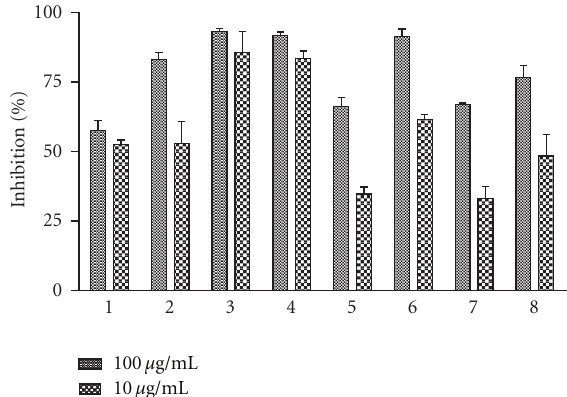
Figure 1: Trypanocidal activity of fractions 1–8 of Mikania micrantha on T. cruzi